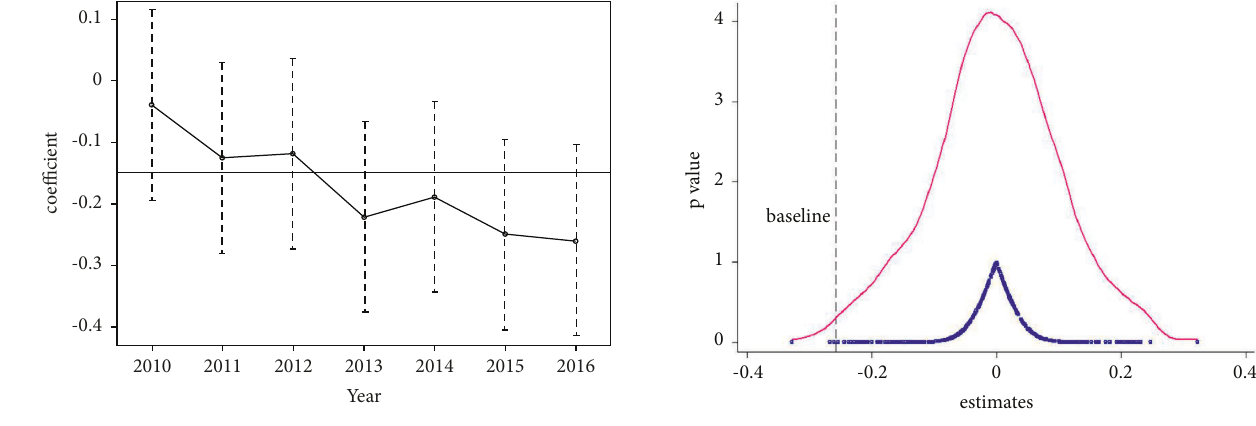
Figure 2: Parallel trend analysis chart.